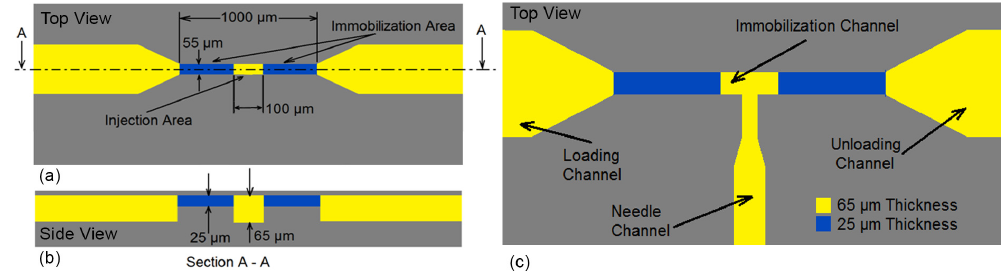
Figure 2. ( a , b ) The schematic design of the immobilization system. The narrowed channel had 25 µm depth with 55 µm width. The depth in the middle of the narrowed channel with length of 100 µm was increased to 65 µm where called as “injection area”. ( c ) The microinjector channels composed of four channels: Loading channel, needle channel, immobilization channel and unloading channel.